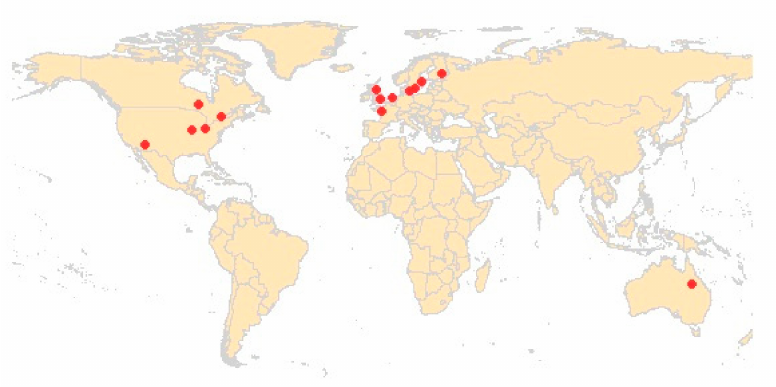
Figure 2. World map indicating where the selected studies were conducted.